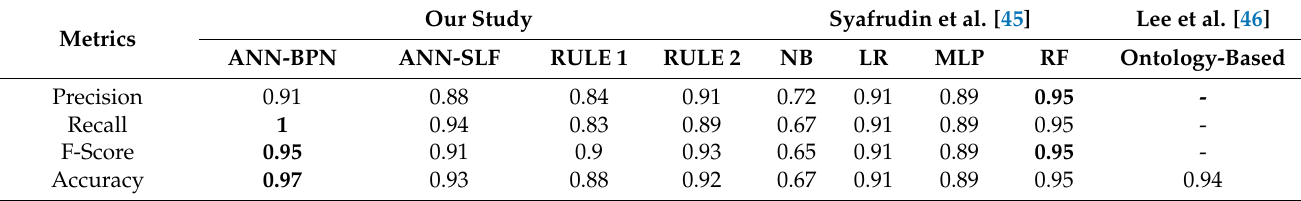
Table 9. Comparison with earlier work that utilized the same injection molding